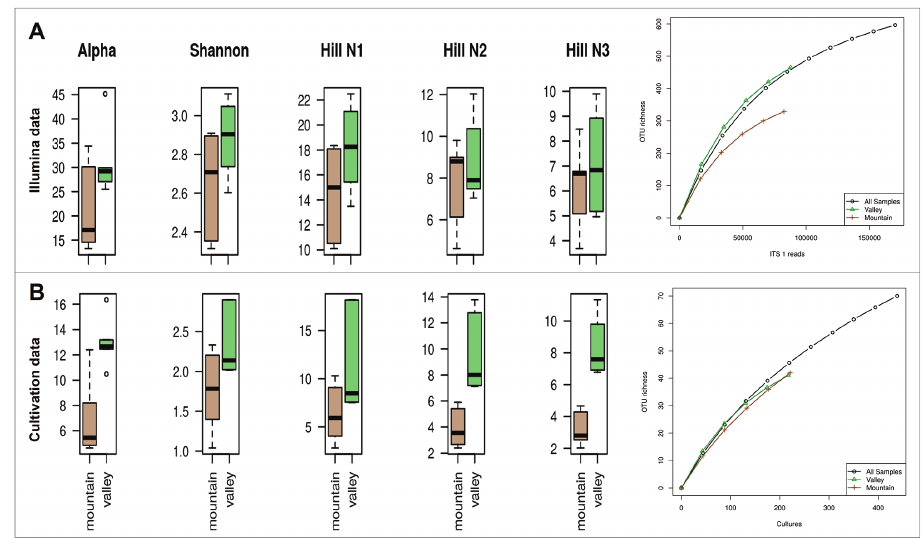
Figure 1. Diversity indexes and accumulation curves for a Illumina and b cultivation data of fungal leaf-inhabiting endophytes of beech. Except of the accumulation curves of cultivation data, both methods revealed a clear and partly significant trend of higher fungal diversity at the valley